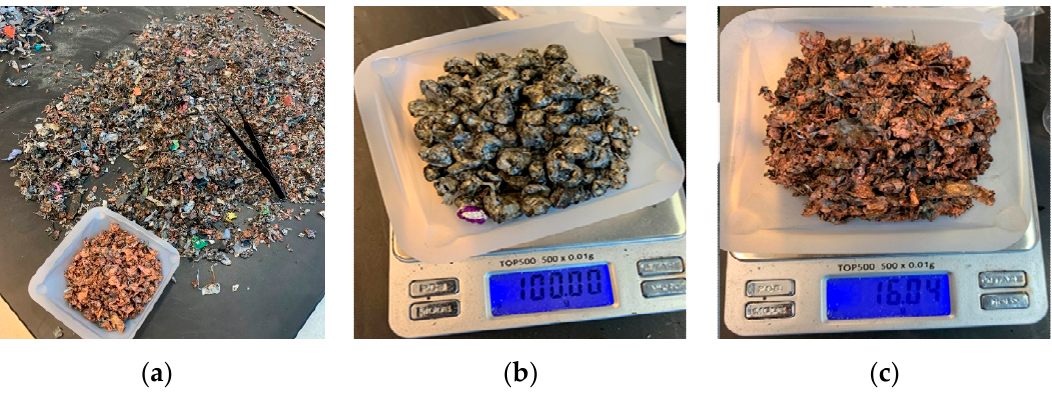
Figure 1. Material obtained from shredded scrap, ( a ) fluff, ( b ) separated Al, ( c ) separated Cu.